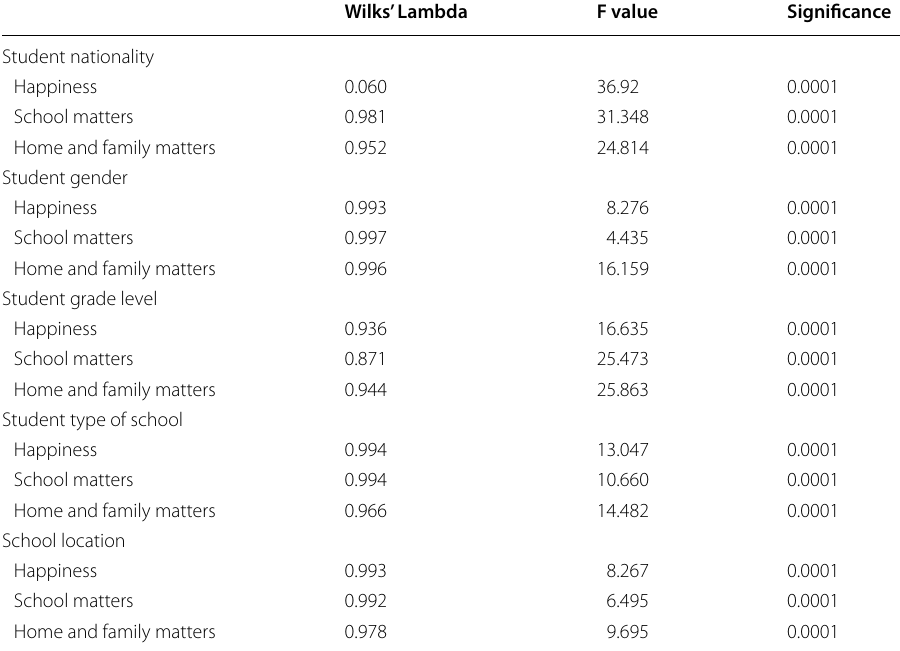
Table 7 MANOVA Wilks’ Lambda for each construct and student category Wilks’ Lambda F value